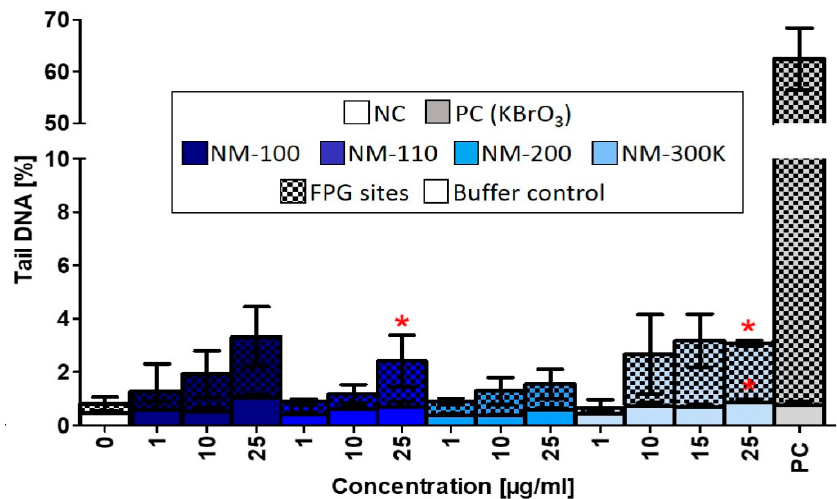
Figure 7. DNA damage evaluated by alkaline comet assay modified with FPG after 24-h exposure to NMs. Buffer controls represent DNA strand breaks. FPG sites corresponding to oxidized purines were obtained by subtracting the % tail DNA of slides incubated with the buffer only from % tail DNA of slides treated with FPG enzyme. Data are reported as the average of the median values of % tail DNA. Statistical significance was analyzed by ANOVA followed by Dunnett’s Multiple Comparison. p < 0.05.